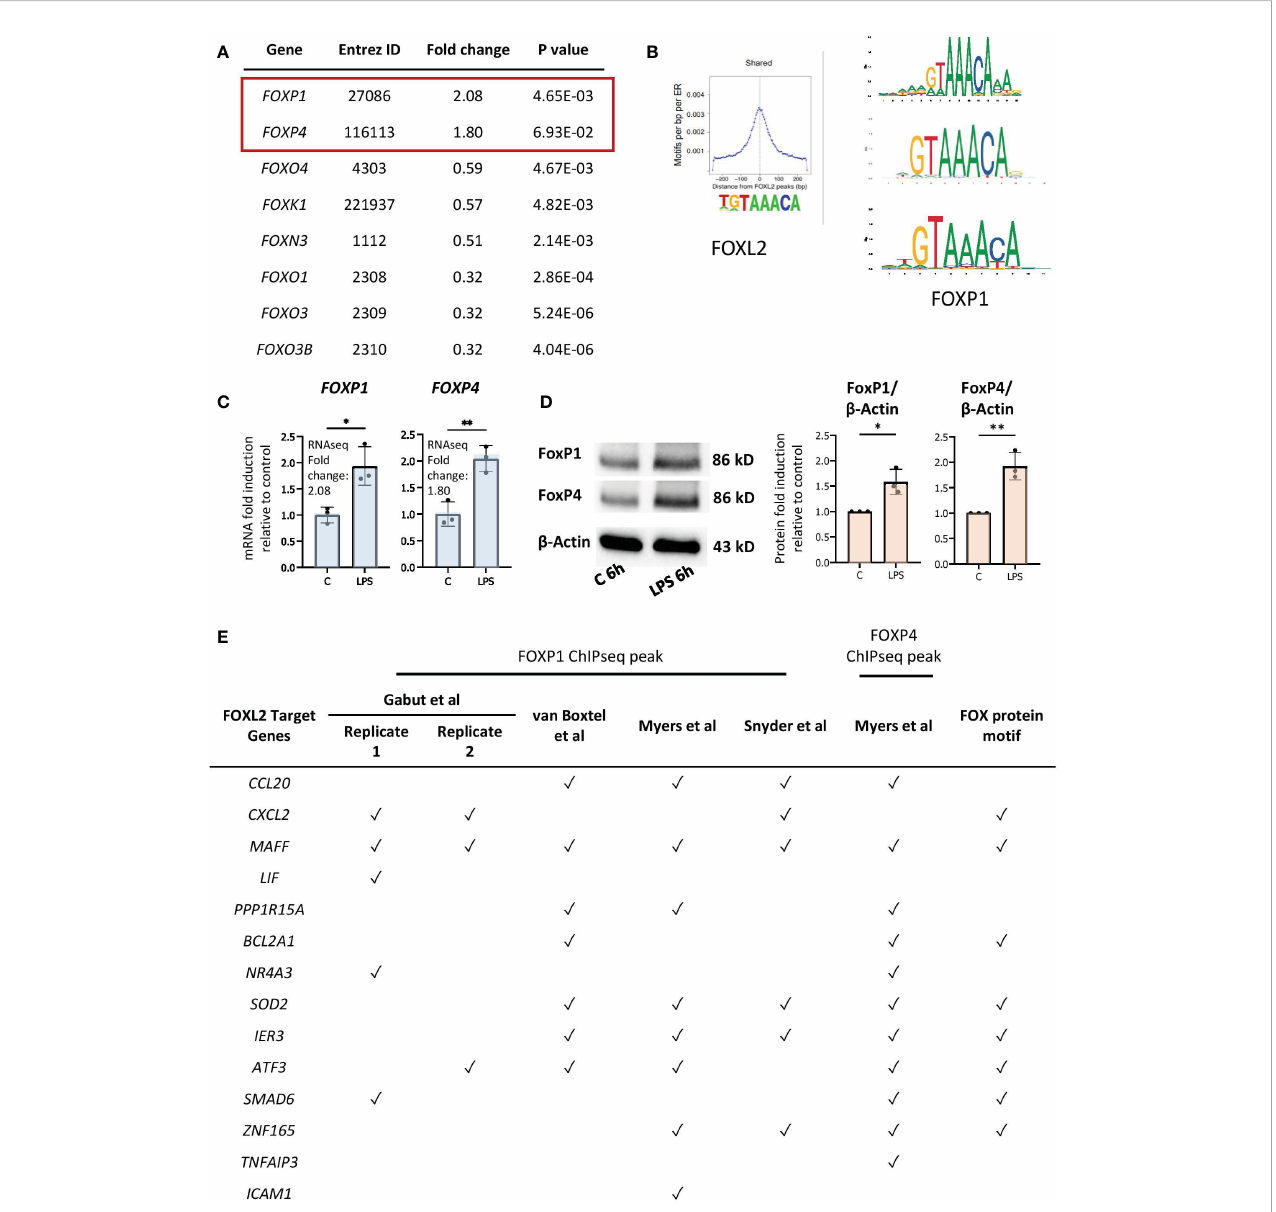
FIGURE 5 FOXP1 and FOXP4 binding sites are present in regulatory regions of network genes. (A) Up- and downregulated genes by LPS encoding FOX transcription factors in our RNAseq data. (B) Conserved motifs (sequence logos) of FOXL2 (left, retrieved from Carles et al. (49)) and FOXP1 (right, retrieved from the JASPAR 2020 database). (C) RT/qPCR analysis of LPS-regulated expression of genes encoding the FOX transcription factors, FOXP1 and FOXP4. Data representative of 2 or 3 biological samples. Graphics are mean ± SD from 3 technical replicates from a representative sample and paired, two-tailed t-test (Student ’ s t-test) was used (*P ≤ 0.05 and **P ≤ 0.01). (D) Western analysis of FOXP1 and FOXP4 protein expression in vehicle- or LPS-treated neutrophils, as indicated. Blots show the band representing the full-length protein. Data representative of 3 biological replicates. Quanti fi cation shown on right. Graphics are mean ± SD from 3 biological replicates and unpaired, two-tailed t-test was used (*P ≤ 0.05 and **P ≤ 0.01). (E) Presence (marked by a tick) or absence of FOXP1 and/or FOXP4 ChIPseq peak(s) and FOX protein motifs within the network genes in different FOXP1 or FOXP4 ChIPseq datasets performed in various cell